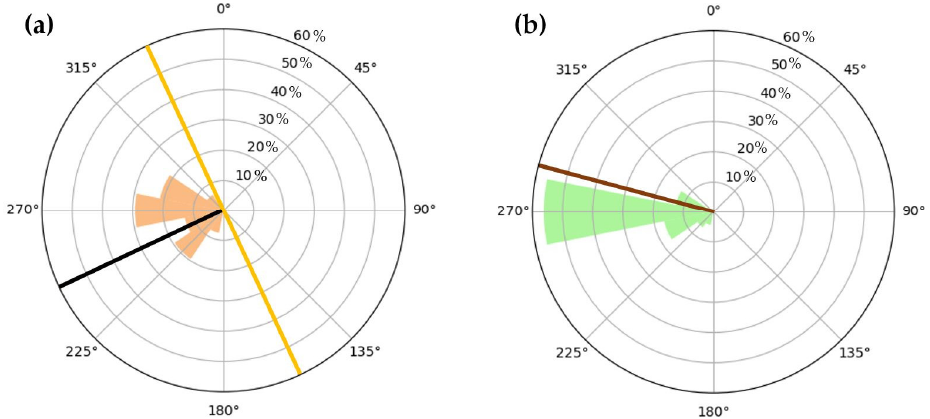
Figure 11. WPT direction distributions for nearshore region ( a ) and reef ( b ). For the nearshore region, the approximate shoreline angle is shown in yellow, with shoreline normal in black. For the reef, the reef crest angle is shown in brown.